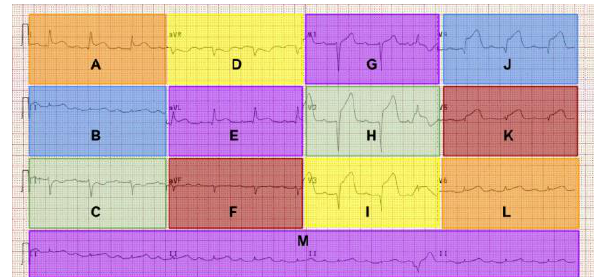
Figure 2. AOIs mapped onto ECG leads. Labelled A-M